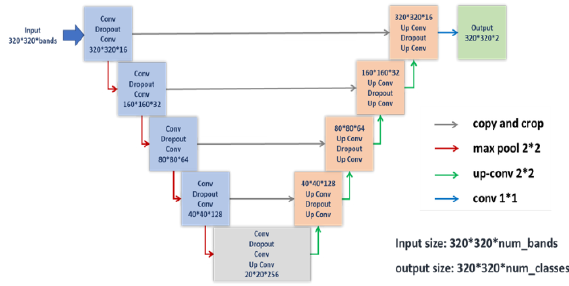
Figure 4. Simplified block diagram of the modified U-Net model.